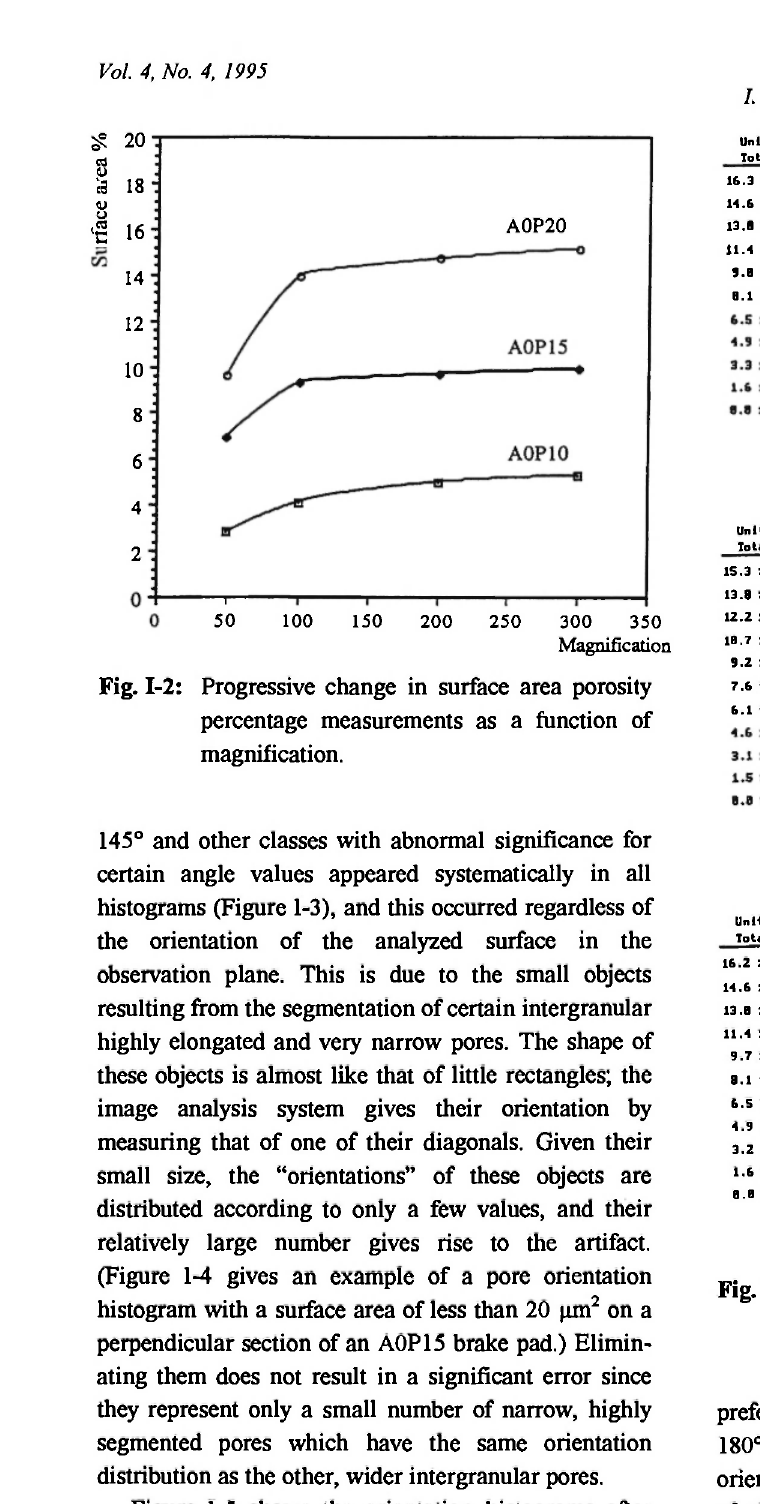
Fig. 1-3: Orientation distribution histograms of the Α0Ρ pads (520 fields; all